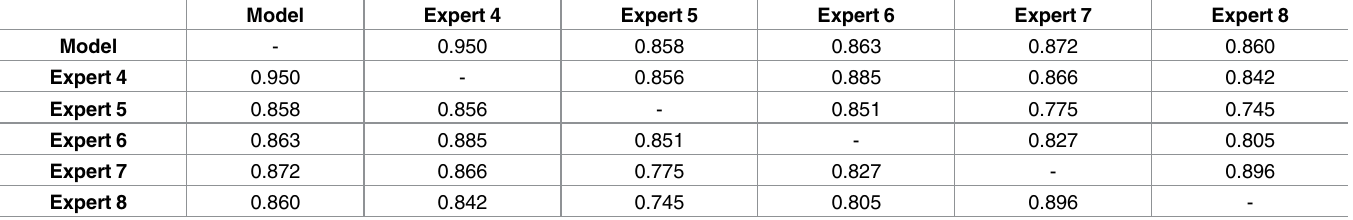
Table 5. Pearson’s correlation (r) between the five new expertsscores and the output of the fuzzy subsystem 2 –level of running experience in the real dataset (n =